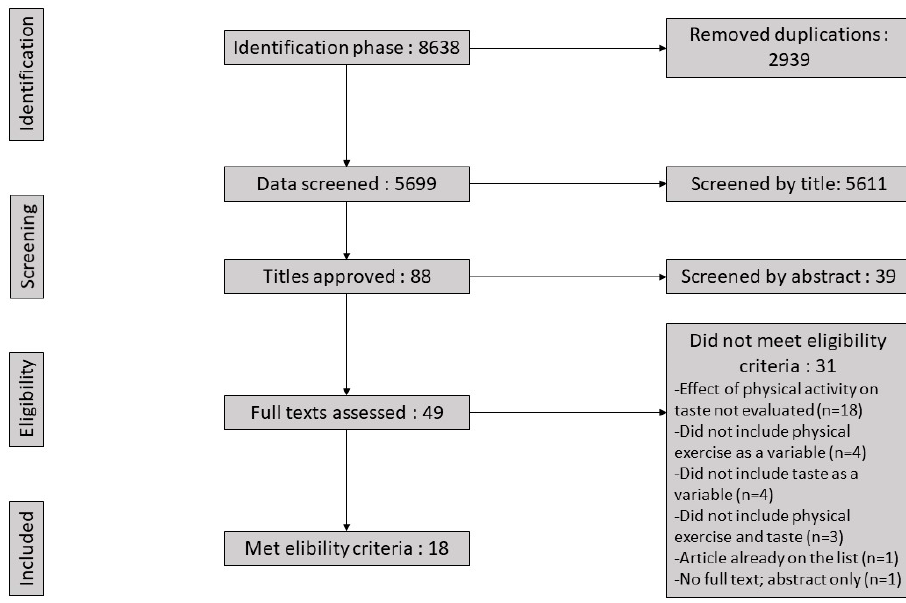
Figure 1. Systematic review flowchart.2.3. Data Gathering and Analyses.